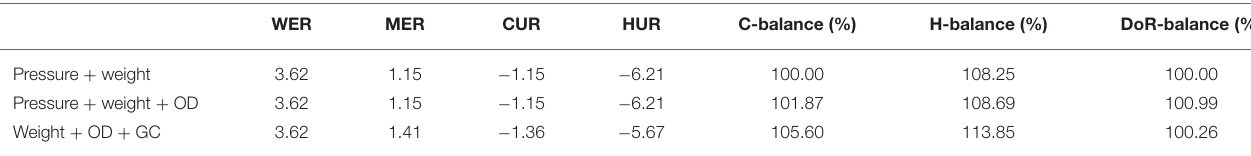
TABLE 4 | Comparison of the volumetric uptake and production rates and mass balances for the three methods for M. marburgensis DSM 2133 (65 ◦ C, OD). WER